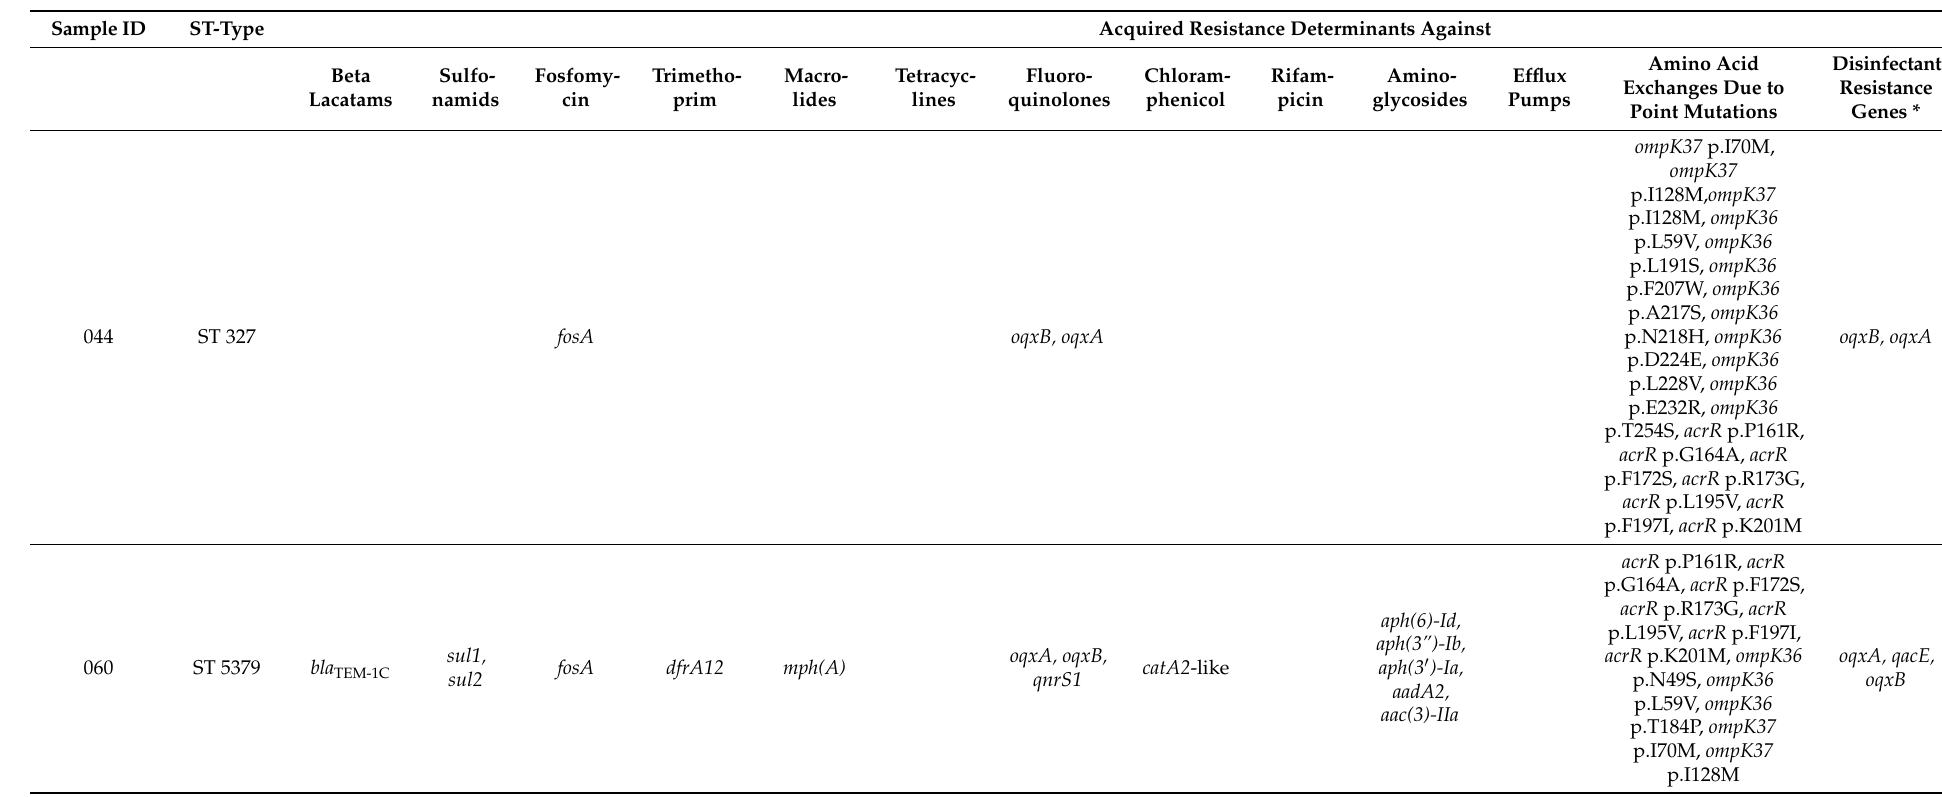
Table A2. Analysis of antimicrobial resistance determinants, ordered by strain and MLST type, of the assessed K. pneumoniae isolates. ST = Sequence